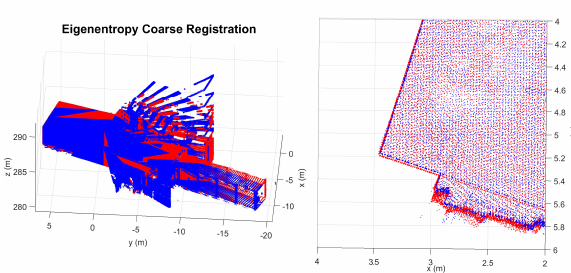
Figure 10. Coarse registration performed from the eigenentropy on the Hall dataset.